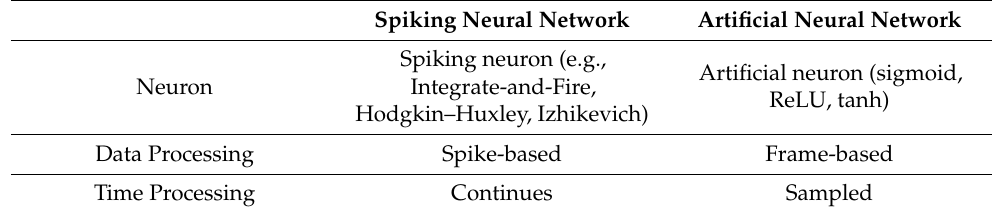
Table 1. Comparison of SNNs and ANNs.